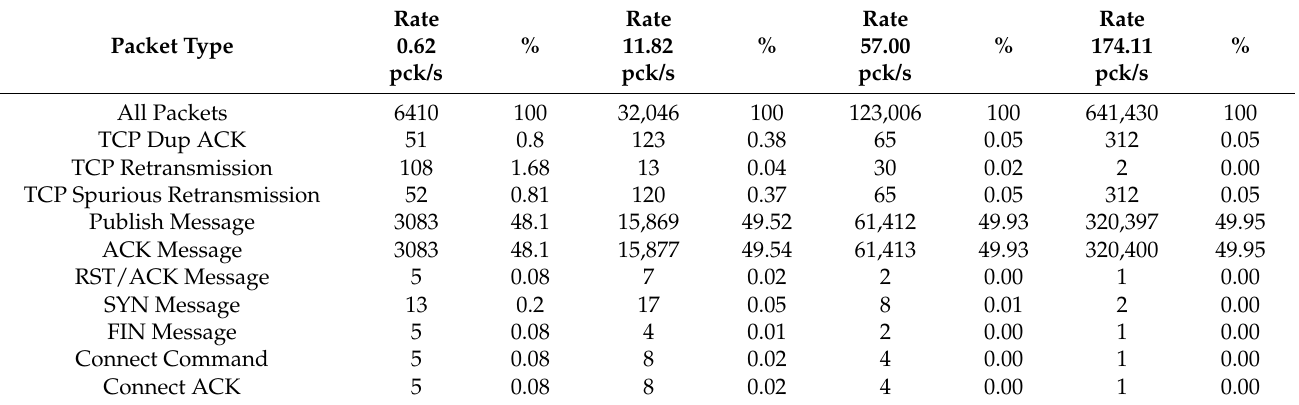
Table 3. Packet load and statistics per packet type for four different scenarios.